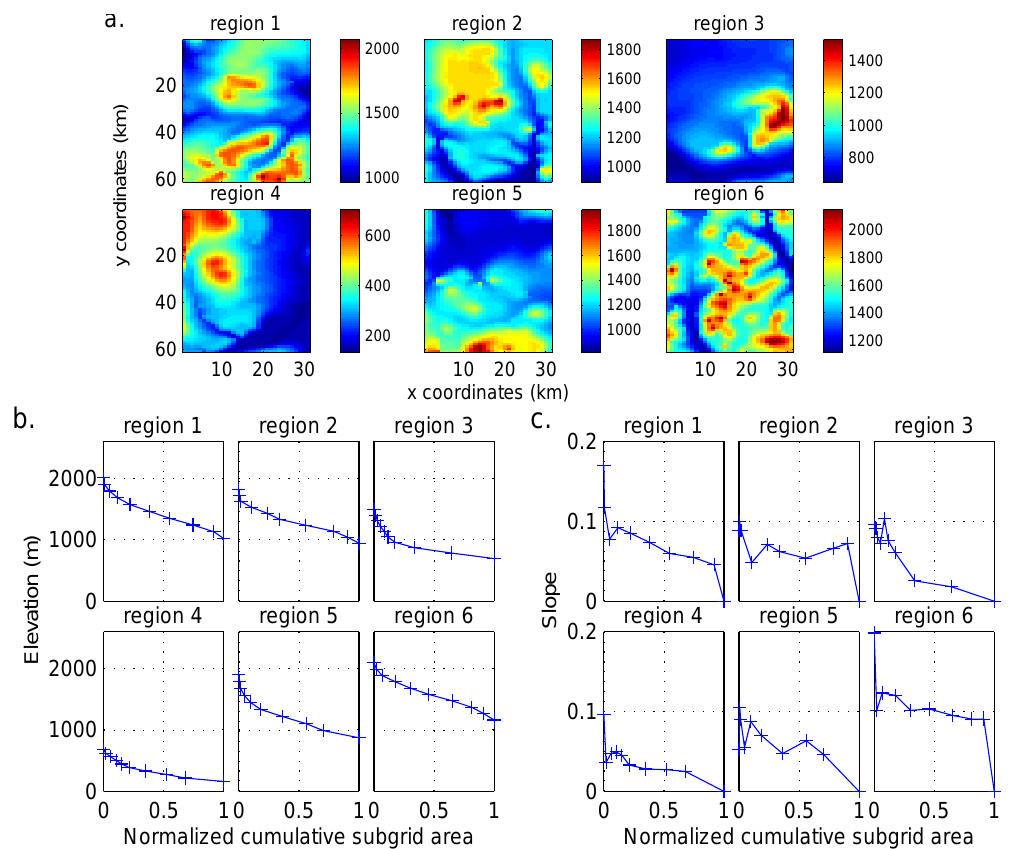
Figure 4. Topography characteristics for six regions over the Canadian Rockies. (a) summarizes surface elevations, (b) the hypsometric curves, and (c) the mean slope for each hypsometric